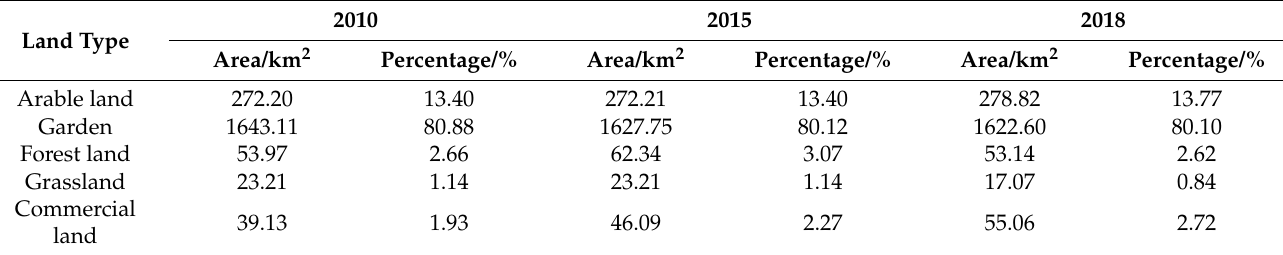
Figure 5. Comparison of measured and simulated runoff at periodic and validation periods. Table 4. Statistical table of land-use types in different years.